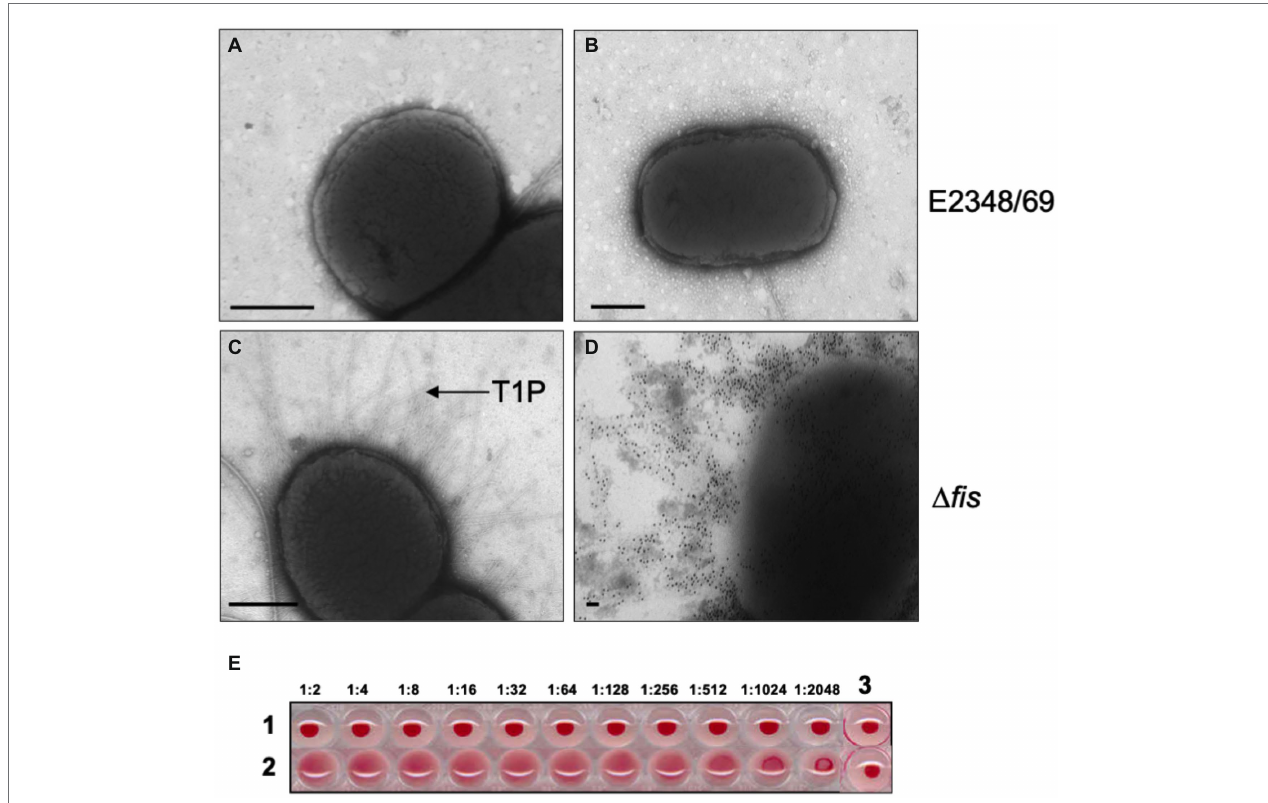
FIGURE 2 | Transmission electron microscopy and hemagglutination. (A,B) Negative staining and immuno-staining of E2348/69 showing no production of T1P. (C,D) Negative staining and immuno-gold labeling of E2348/69 Δ fis producing abundant T1P. Magnification bars, 0.5 μ m. (E) Hemagglutinations (HA) showing (1) E2348/69, which does not produce T1P and consequently does not produce HA; (2) E2348/69 Δ fis produces T1P and shows strong HA titer. (3) RBCs alone as negative control. The HA assay was done with 1% guinea pig red blood cells (RBCs) with the bacteria in the dilutions noted above.